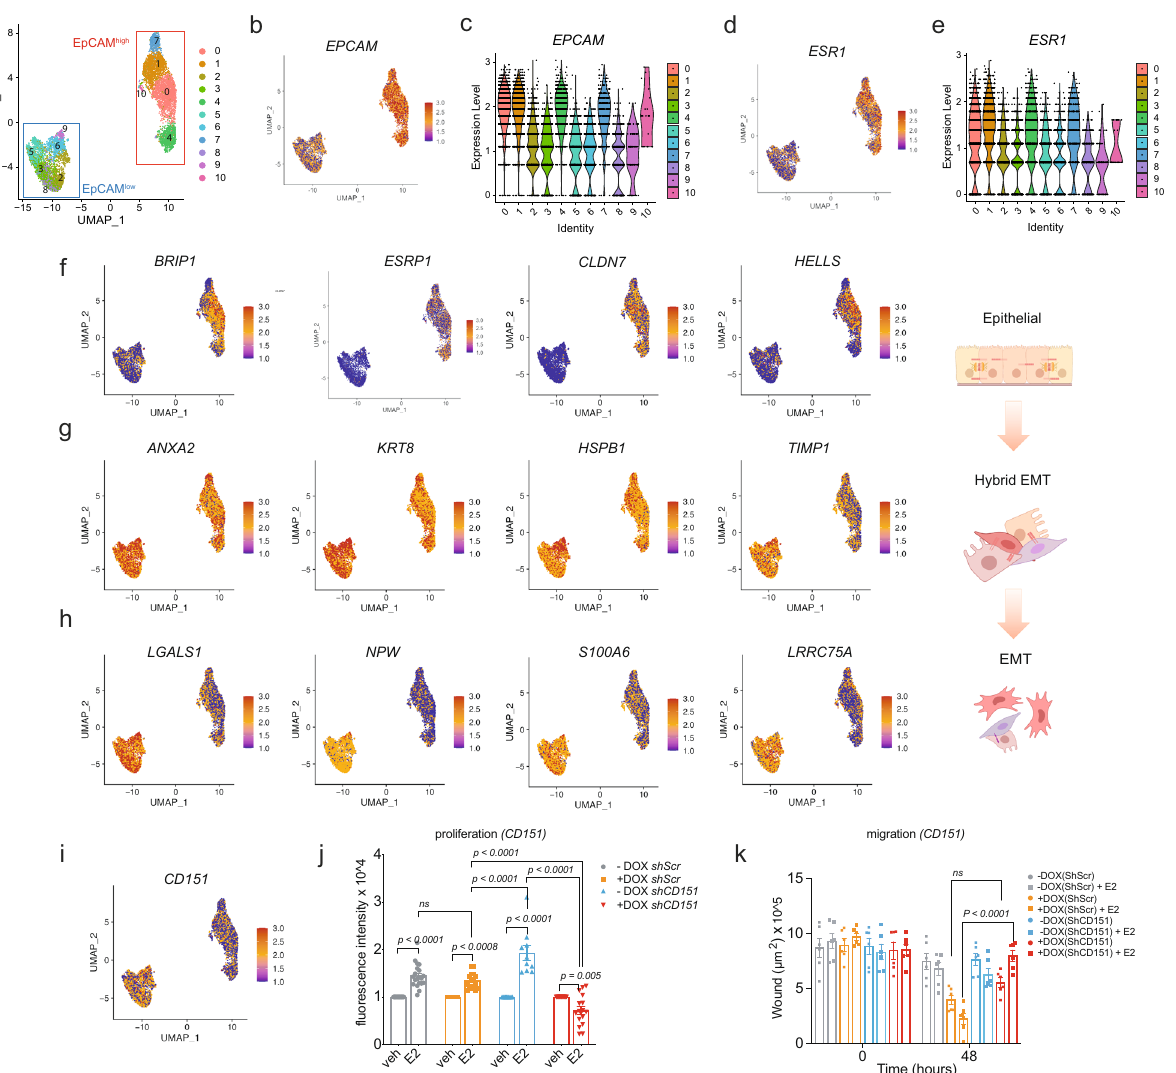
Fig. 6 ZEB1 induces different EMT states in breast cancer cells with CD151 as a potential marker of early EMT. a – h show different aspects of scRNA-seq analysis of MCF7-V cells expressing ZEB1 after induction with DOX for 5 weeks to obtain EpCAM high and EpCAM low cell populations. a Visualization of the distribution of the merged data sets of both EpCAM high (red rectangle) and EpCAM low (blue rectangle) cell populations, based on the comparison of the transcriptomes of individual cells; the graph was generated by a Uniform Manifold Approximation and Projection (UMAP); the clusters are color-coded and numbered, and each dot represents a single cell. b Single cells expressing EPCAM in different clusters. c Violin plot of the EPCAM transcript levels across different clusters; note that the steps at low levels of expression are due to rounding off after normalization. d Single cells expressing ESR1 in different clusters. e Violin plot for ESR1 transcripts with the same color code and numbering as in a . f – h Expression of top markers of epithelial ( f ), hybrid EMT ( g ), and mesenchymal-like ( h ) states in breast cancer cells upon induction of an EMT by ZEB1 expression. The legend shows a color gradient of normalized expression. The accompanying scheme of the EMT on the right was created with BioRender.com. i Expression of the mRNA for the CD151 cell surface marker across various subpopulations. j Relative proliferation of − DOX and + DOX cells with or without CD151 knockdown exposed to veh or E2 for 72 h (means ± SEM, n = 4 biologically independent experiments averaged from a total of n = 16 technical replicates). Statistical signi fi cance was determined with two-way ANOVA. p values are indicated above the bars. k Quanti fi cation of the effect of CD151 knockdown on the migration of MCF7-V-ZEB1 cells treated with veh or E2 in a wound-healing assay; the Y axis shows the remaining wound area into which cells have not yet migrated (means ± SEM and n = 3 biological replicates each including n = 2 technical replicates). Statistical signi fi cance was determined with a two-way ANOVA. p values are indicated above the bars. Source data are provided as a Source Data fi